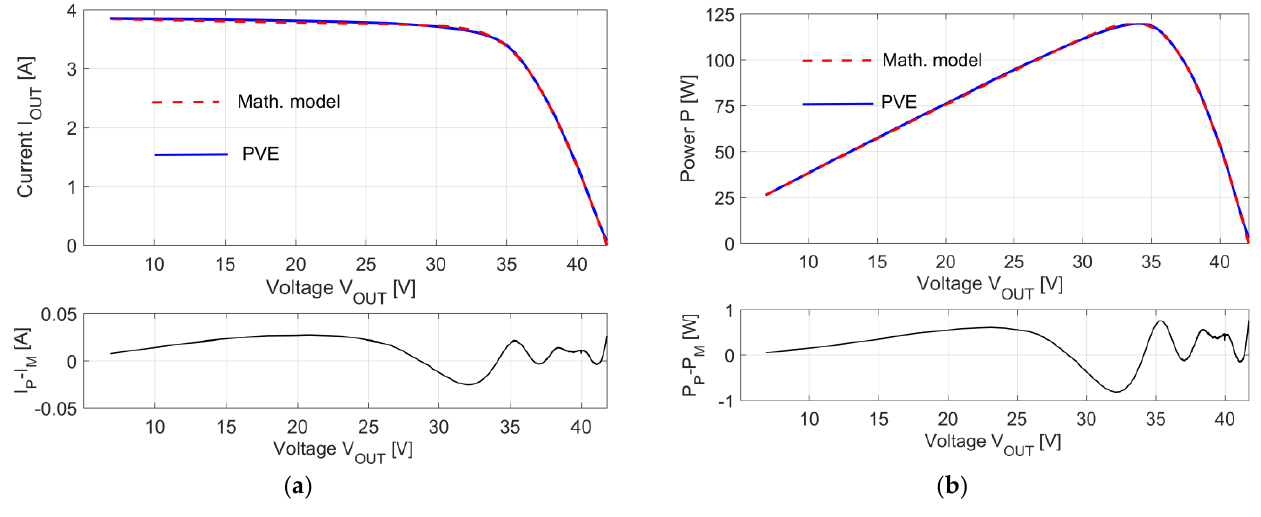
Figure 13. Comparison of emulated characteristics by PVE (solid blue line) and generated by mathematical model (dashed red line): ( a ) Upper curves represent I OUT = f (V OUT ) function, bottom curve represents absolute values of the I P -I M difference; ( b ) Upper curves represent P OUT = f (V OUT ) function, bottom curve represents absolute values of the P P -P M difference.